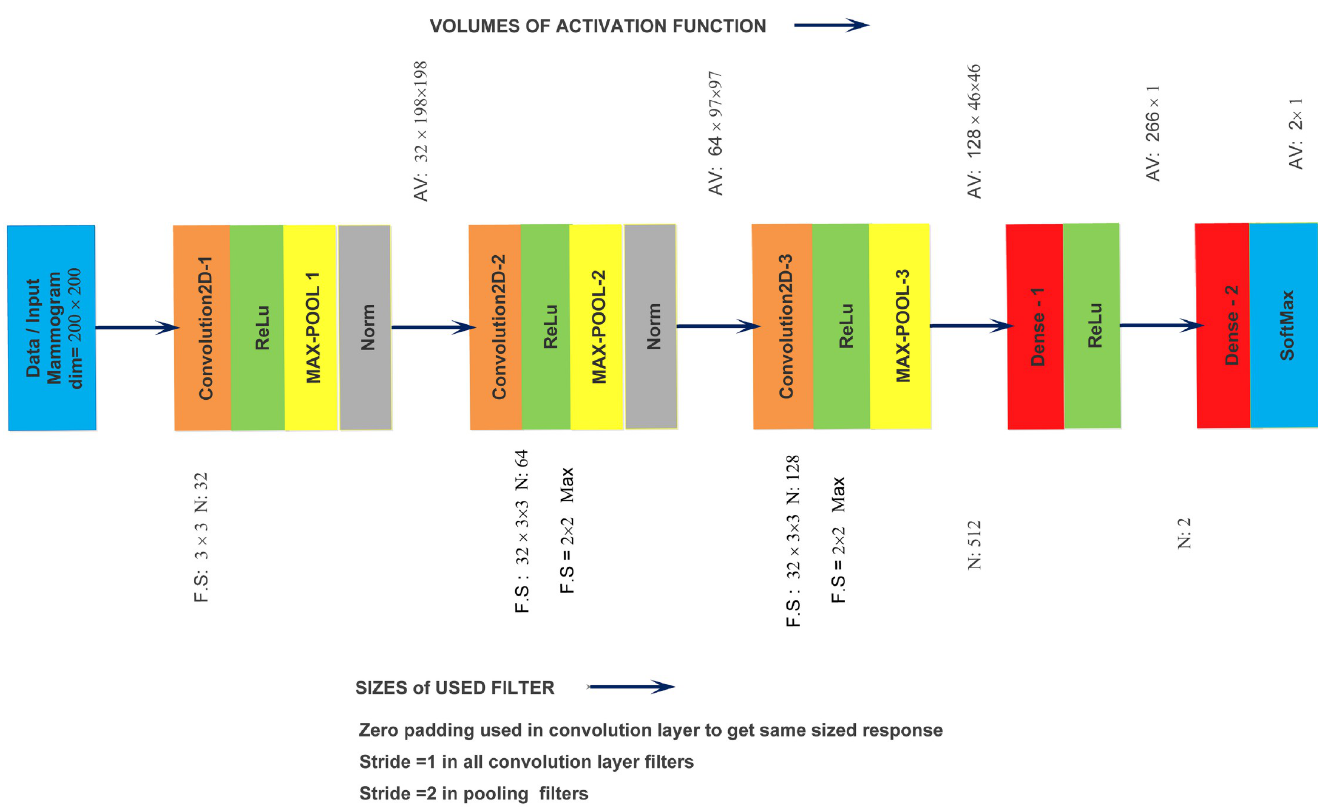
Fig 4. The implementation of designed ConvNet architecture containing convolution2D, ReLu, max-pooling, batch normalization and softmax layer for the classification of breast masses.